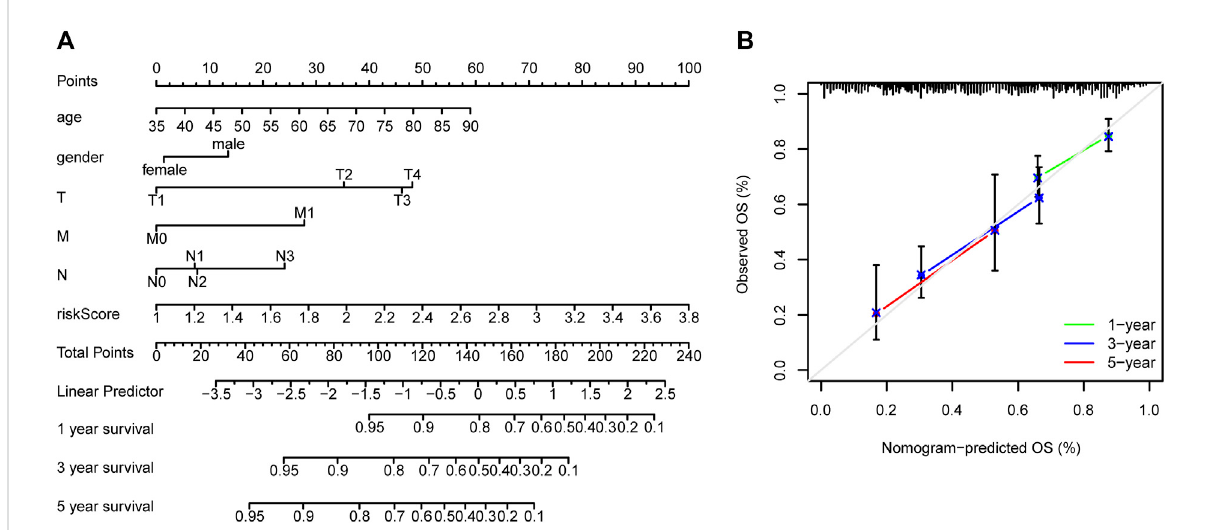
FIGURE 6 Prediction nomograms. (A) Nomogram model based on clinicopathological features and risk scores of patients with gastric cancer in TCGA dataset to predict their prognosis. (B) Calibration curve of the nomograms for predicting overall patient survival. The diagonal dotted line represents the ideal